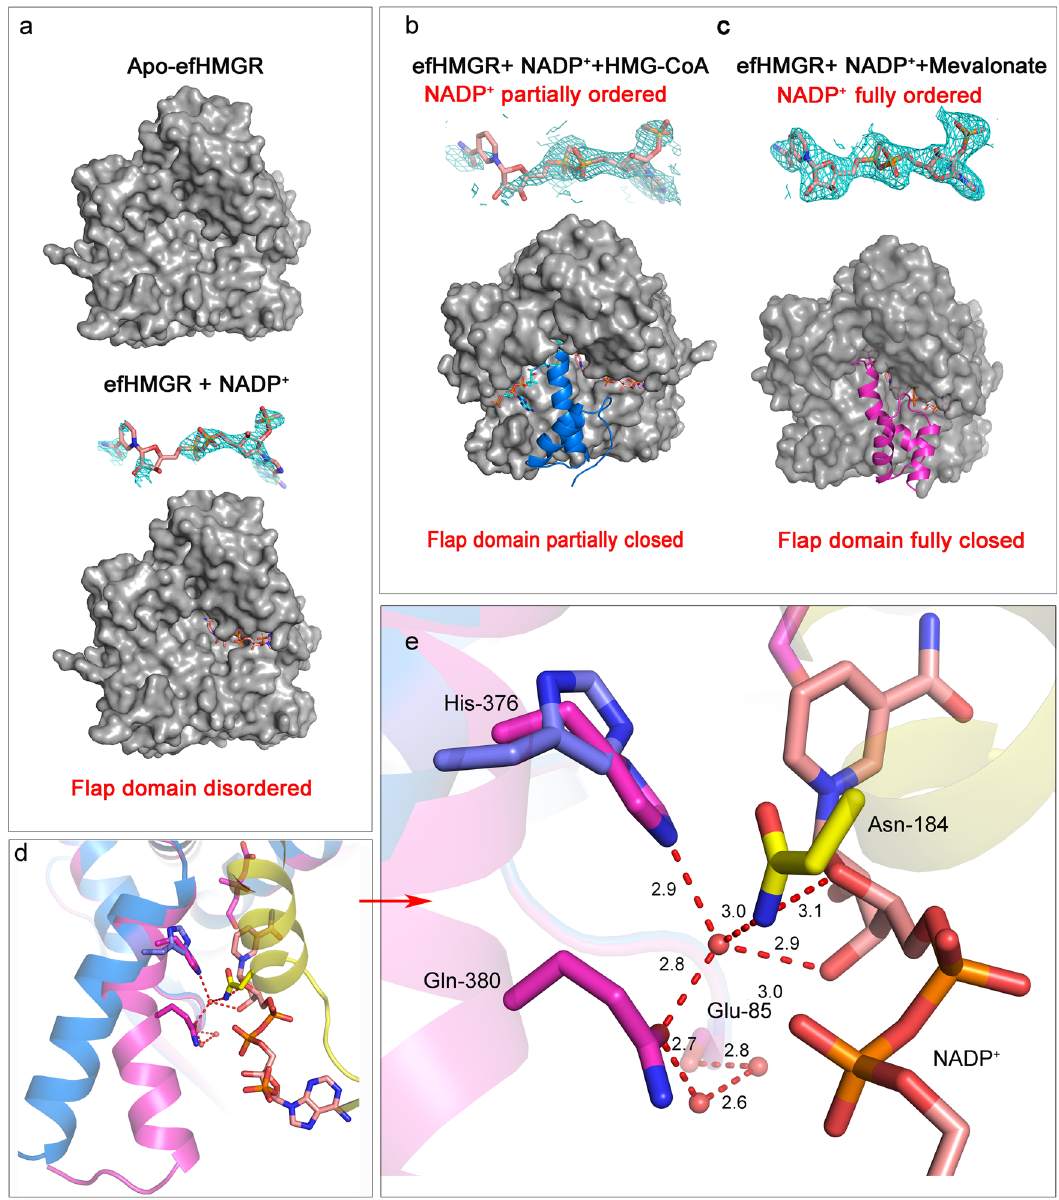
Fig. 3 Role of NADP + in fl ap domain closure. a The fl ap domain is disordered in the apo and NADP + bound forms in efHMGR. With only NADP + bound in the active site, the fl ap domain is disordered and the nicotinamide- ribose moiety in NADP + does not have observable 2Fo-Fc density. b In the presence of HMG-CoA and NADP + , the fl ap domain is partially closed (blue). In this case the nicotinamide-ribose moiety of NADP + is also disordered as seen by the 1.0 σ 2F o -F c density . c The fl ap domain is fully closed (magenta) in the presence of mevalonate and a fully ordered NADP + molecule as evident by the 2Fo-Fc density at 1.0 σ . d Superposition of the HMG-CoA + NADP + bound monomer on the mevalonate + NADP + bound monomer suggests that the partially closed fl ap domain (blue) is rotated 15° as compared to the fully closed conformation (magenta). e The interactions that stabilize the fully closed fl ap (magenta) in the presence of a well-ordered NADP + molecule are shown here. Several residues (His-376 and Gln-380) in the fully closed fl ap interact with the nicotinamide-ribose moiety of NADP + via water-mediated interactions. Residue Asn-184 present in the small domain is seen to clamp down over the nicotinamide-ribose moiety and also participate in the water-mediated interactions. The catalytic His-376 is placed farther away in the partially closed fl ap (blue). Waters are shown as red spheres and hydrogen bond interactions are represented as red dashes and the distances are shown in the nicotinamide ribose-oxygen and clamps the cofactor down in (Fig. 3d). With mevalonate and NADP + in the active site (Dimer the active site. Several direct and water mediated hydrogen bond CD), the fl ap domain is seen in the fully closed conformation with interactions connect the cofactor with the fl ap domain of the His-376 (C) at hydrogen bond distance from the catalytic Ser-88 enzyme. While the nicotinamide-ribose 2'-OH hydrogen bonds (D). The 2Fo-Fc electron density map shows a well-ordered with Asn-279 (C) (2.9 Å) of the large domain, the nicotinamide- NADP + molecule with B factors comparable to the surrounding residues. The carboxamide group of the nicotinamide ring ribose 3'-OH also interacts with the catalytic His-376 (C) via a hydrogen bonds with the side chain of Asn-213 (D). Also, the well-ordered and multiply H-bonded water molecule (His-376 carboxamide group of Asn-184 (D) hydrogen bonds (3.1 Å) with (2.9 Å), Gln-380 (C) (2.8 Å), ribose-3'-OH (2.9 Å) and Asn-184